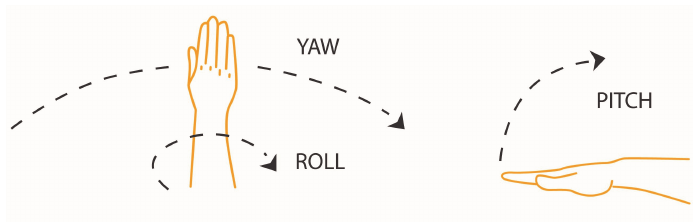
Figure 3. Hand’s different